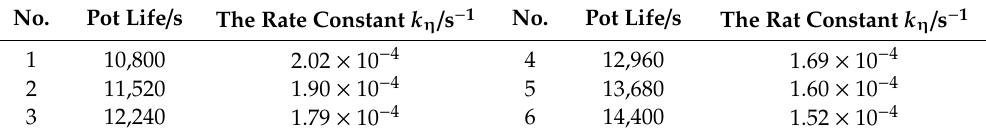
Table 4. Rate constant for viscosity build-up ( k η ) that satisfies di ff erent pot lives for HTPB / HDI-trimer / DABCO system at 35 ◦ C.